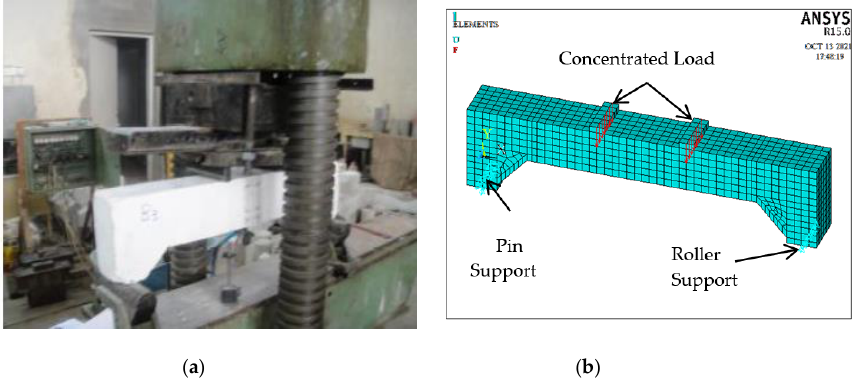
Figure 8. Experimental and numerical modelling layouts of supports and loadings of a typical non-prismatic RC beam. ( a ) Experimental setup. Reprinted from Ref. [23]; ( b ) Numerical modelling setup.